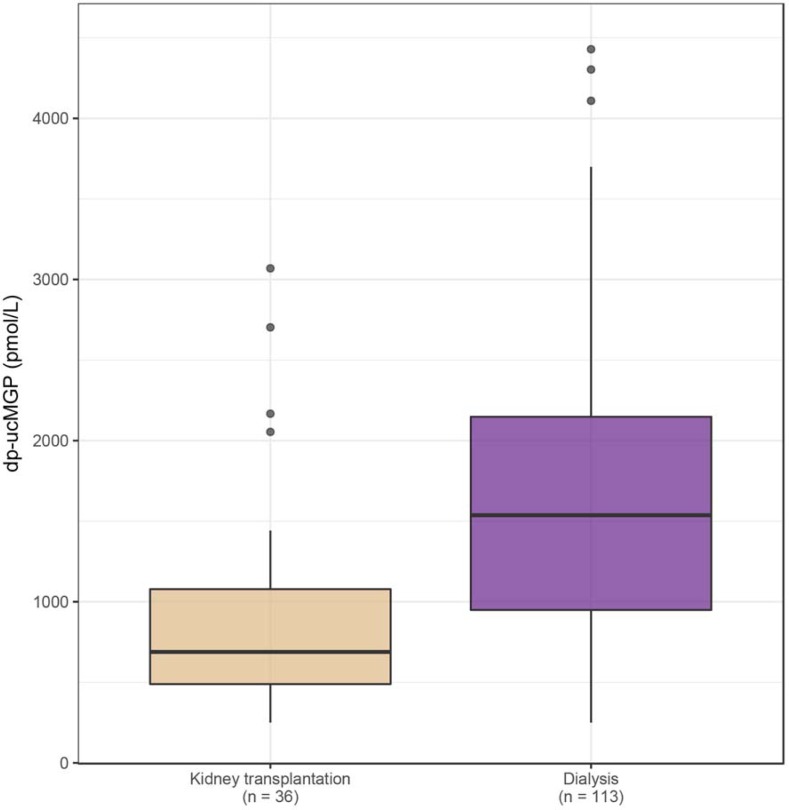
Dp-ucMGP levels stratified by renal replacement therapy, as boxplots.Kidney transplant recipients (n = 36): sand-color boxplot, and both patients on hemo- and peritoneal dialysis (n = 113): purple boxplot. Median values of dp-ucMGP: 689 and 1537 pmol/L respectively.